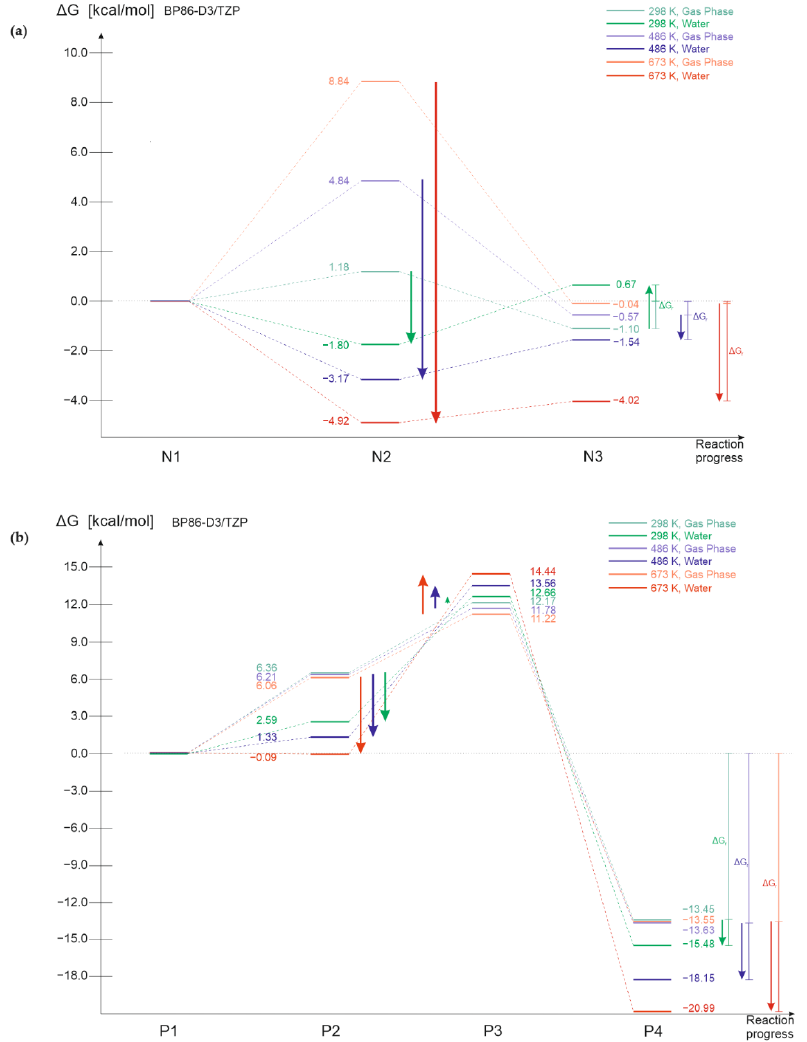
Figure 10. Relative Gibbs free energies of ( a ) nylon 6 and ( b ) PHB structures obtained for gas phase (low-saturation colors) and water presence (high-saturation colors) in different temperatures; some of the data was neglected aiming the clarity of the picture.